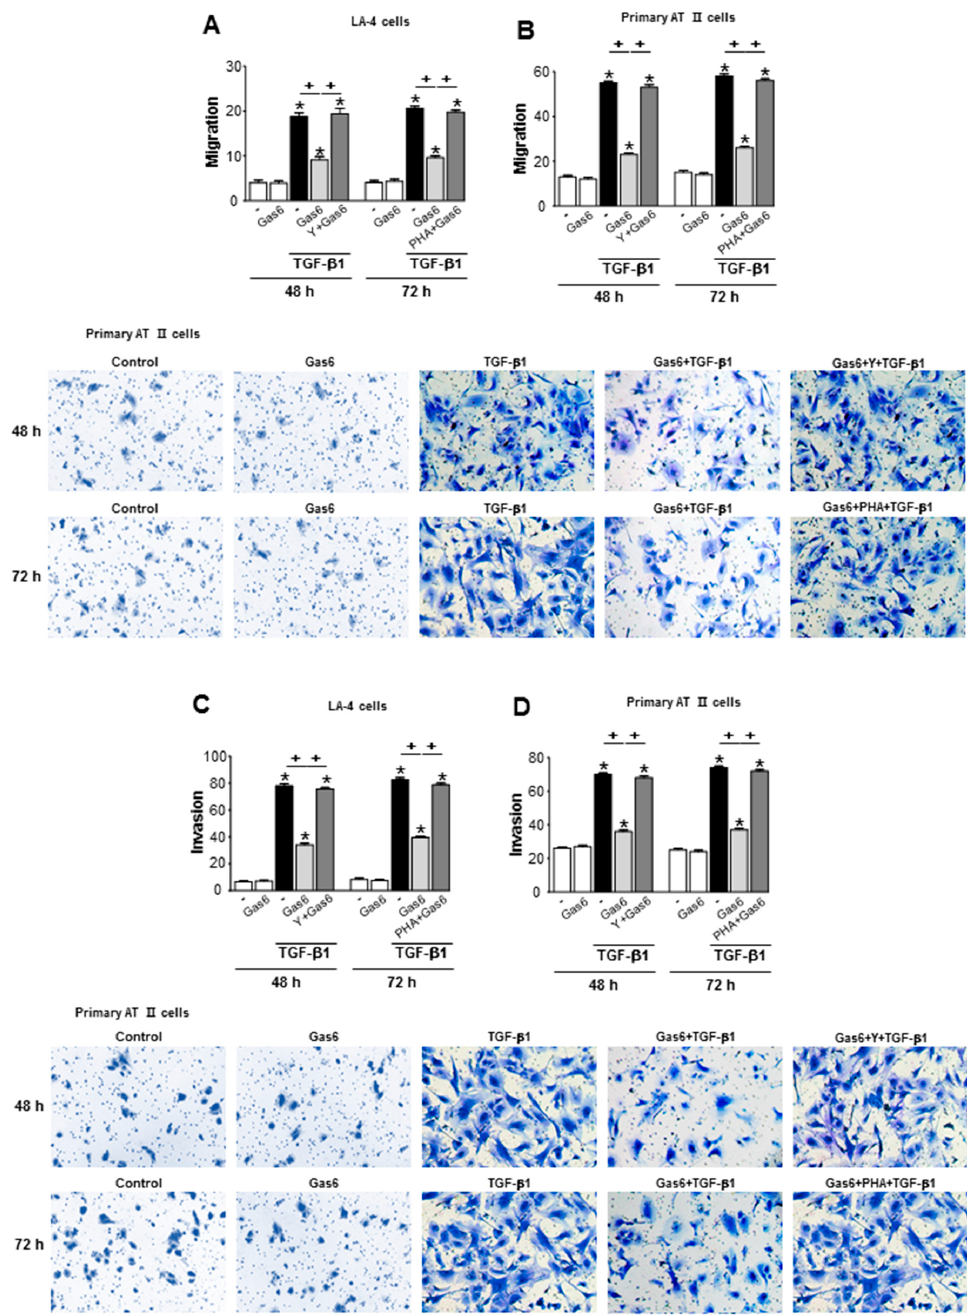
Figure 9. Gas6 / RhoA / HGF signaling inhibits the migration and invasion of lung epithelial cells. ( A – D ) LA-4 or primary AT II cells were treated with 30 µ M Y-27632 for 1 h prior to treatment with 400 ng / mL Gas6 for 20 h and then stimulated with 10 ng / mL TGF- β 1 for 48 h. Epithelial cells were treated with 400 ng / mL Gas6 for 20 h and then stimulated with 10 ng / mL TGF- β 1 for 72 h, with or without 250 nM PHA-665752. The quantification of migrating or invading cells was performed in Transwell chambers. Primary AT II cells were visualized by phase-contrast microscopy for the analysis of migration ( B lower) and invasion ( D lower) abilities, using fibronectin-coated Transwell and Matrigel-coated Transwell plates, respectively. Quantification of migrating cells in A and B upper or invading cells in C and D upper. Values represent the mean ± SEM of three independent experiments. * p < 0.05 compared with control; + p < 0.05, as